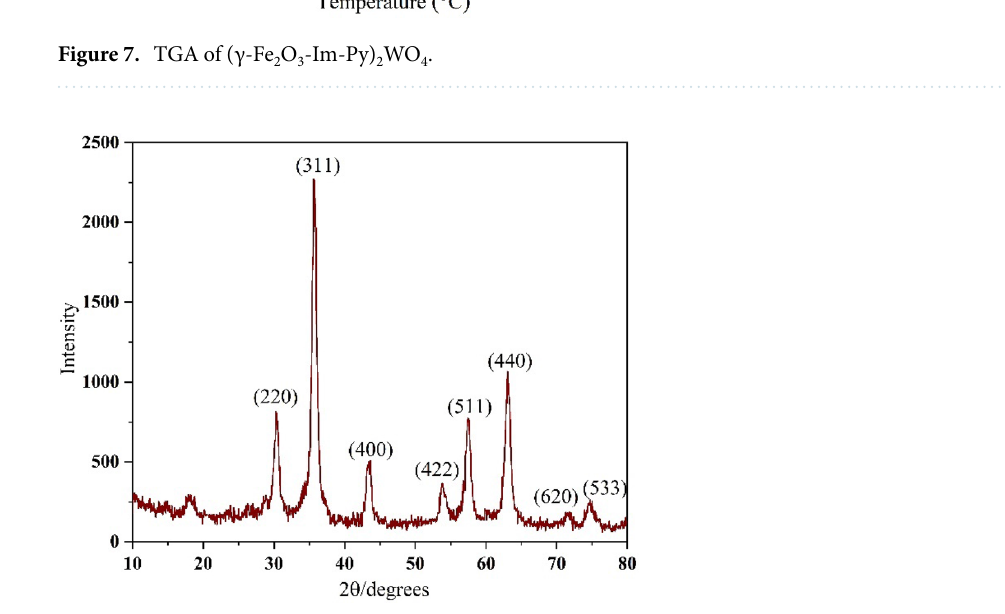
Figure 8. XRD pattern of (γ-Fe 2 O 3 -Im-Py) 2 WO 4